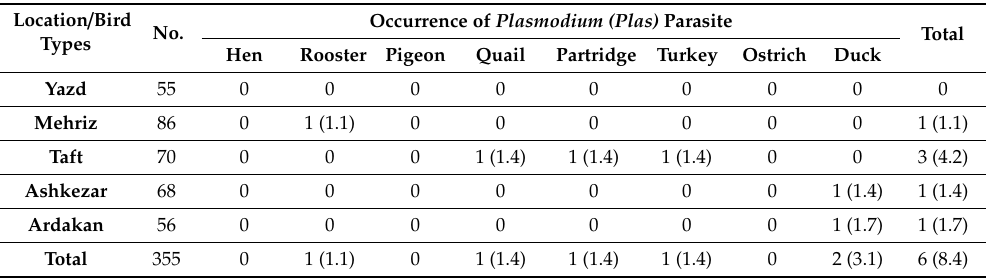
Table 2. Occurrence of Plasmodium (Plas) parasite in eight species of birds located at five counties in Yazd province, central